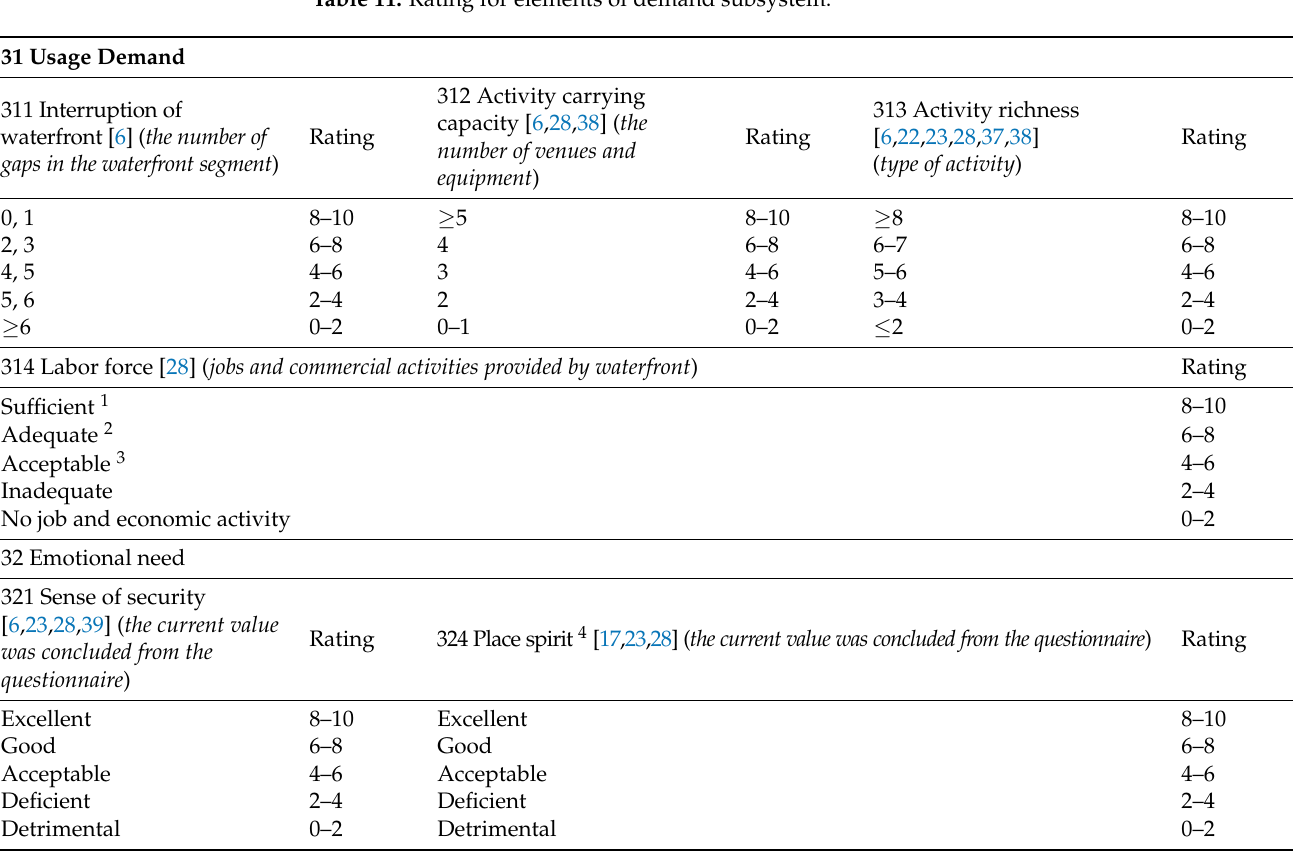
Table 11. Rating for elements of demand